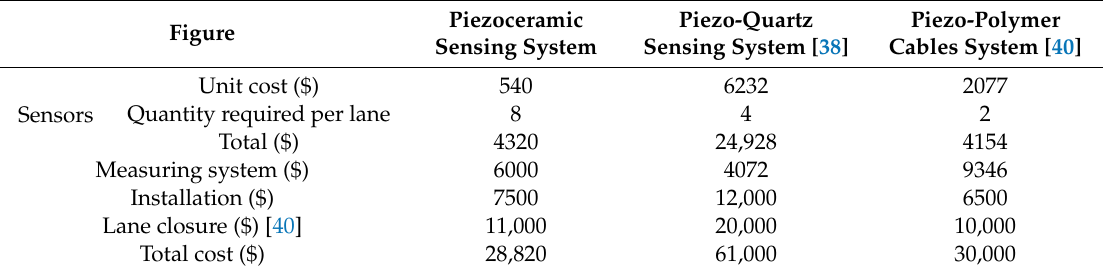
Table 3. Cost comparison of the proposed system with the commercial sensing system. Piezoceramic Piezo-Quartz Piezo-Polymer Figure Sensing System Sensing System [38] Cables System [40] Unit cost ($) 540 6232 2077 4 Sensors